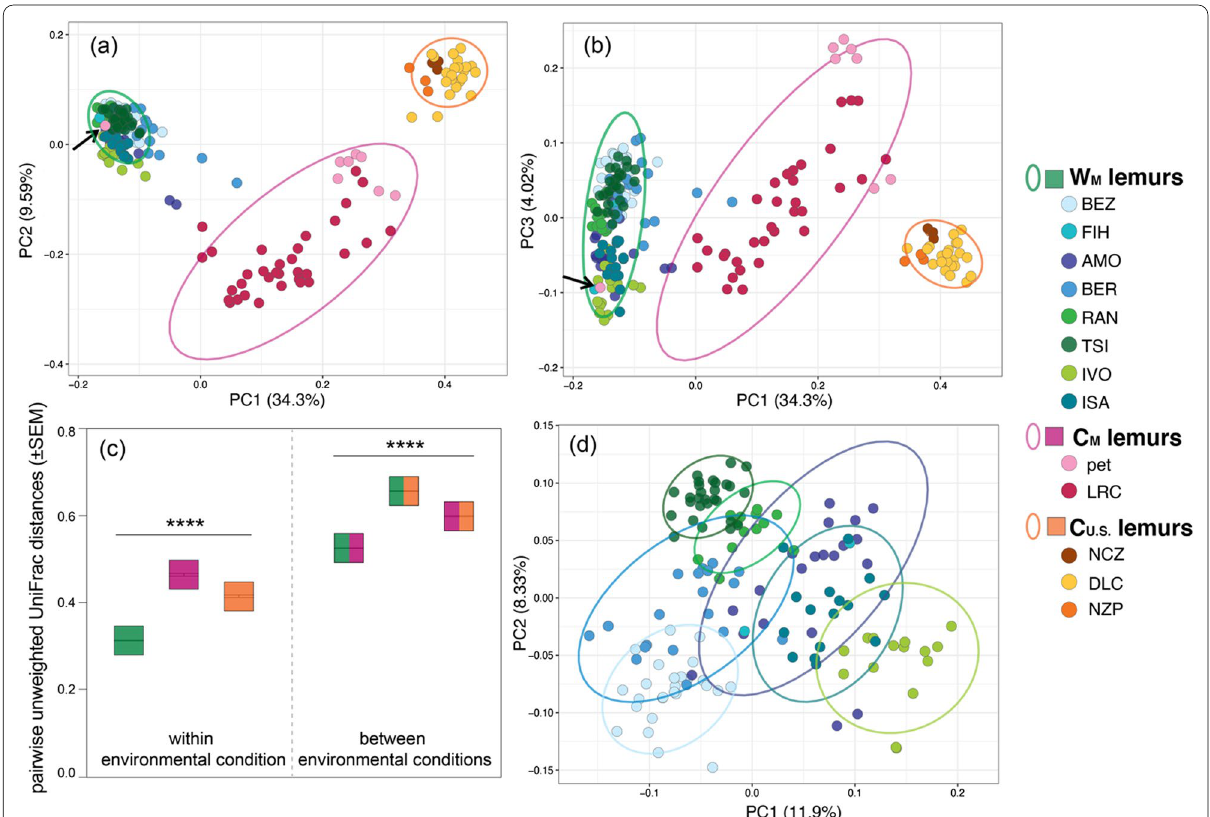
Fig. 4 Beta diversity (unweighted UniFrac distances) of lemur gut microbiota across three environmental conditions—wilderness in Madagascar (W M ; green), captivity in Madagascar (C M ; pink), and captivity in the U.S. (C U.S. ; orange)—that encompass 13 setting (see Table 1 for names of the abbreviated research settings). a , b Principal coordinate plots, showing axes 1 and 2, or 1 and 3, respectively, of individual gut microbial communities colored by setting and encircled by normal data ellipses reflecting environmental condition. c Mean beta diversity distance scores within an environmental condition (single color) and between two environmental conditions (two colors). The center of the box reflects the mean and the error bars represent the standard error of the mean (SEM). d Principal coordinate plots, showing axes 1 and 2, for the eight settings within ± the wilderness condition. Kruskal–Wallis test with Benjamini–Hochberg correction; **** p <